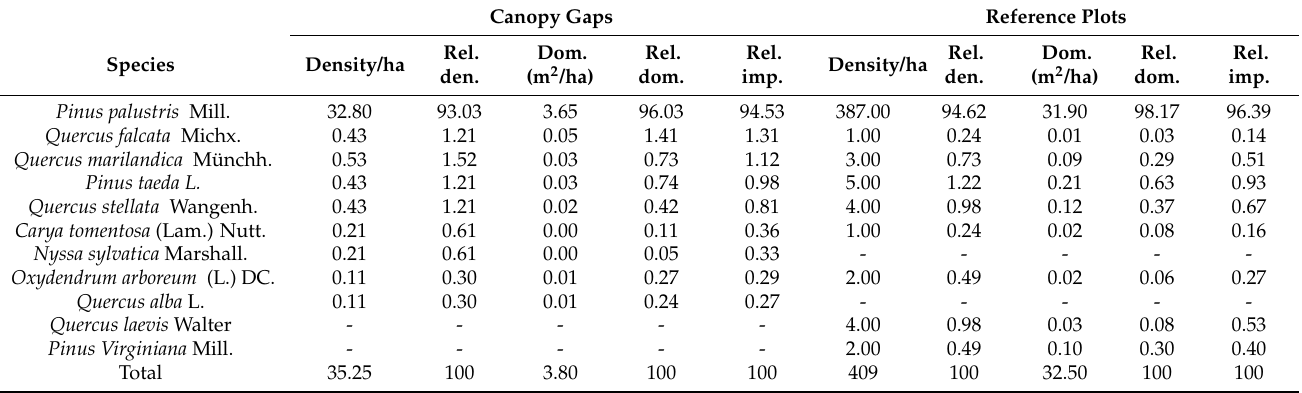
Table 1. Density, relative density, dominance, relative dominance, and relative importance (average of relative density and relative dominance) for trees (stems ≥ 10 cm dbh) for canopy gap and reference (non-gap) plots in a montane Pinus palustris woodland. Canopy Gaps Reference Plots